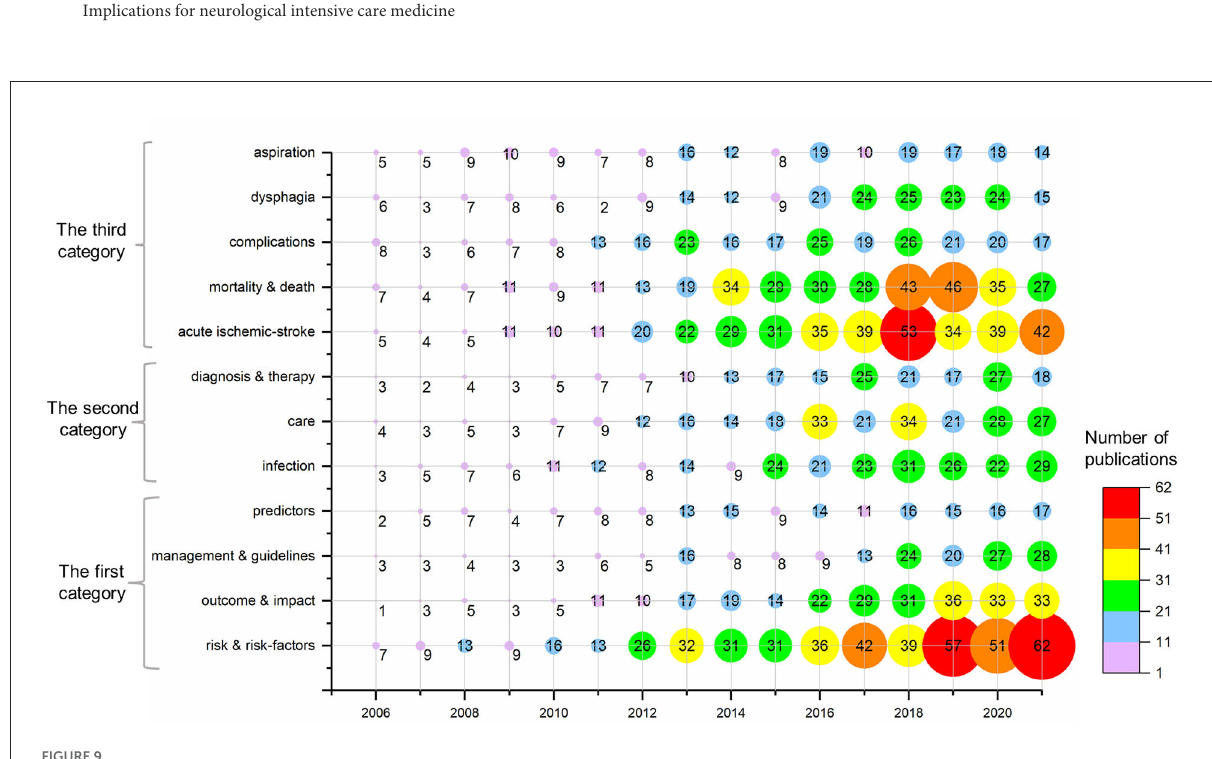
FIGURE9 Bubble charts for 12 high-frequency topic